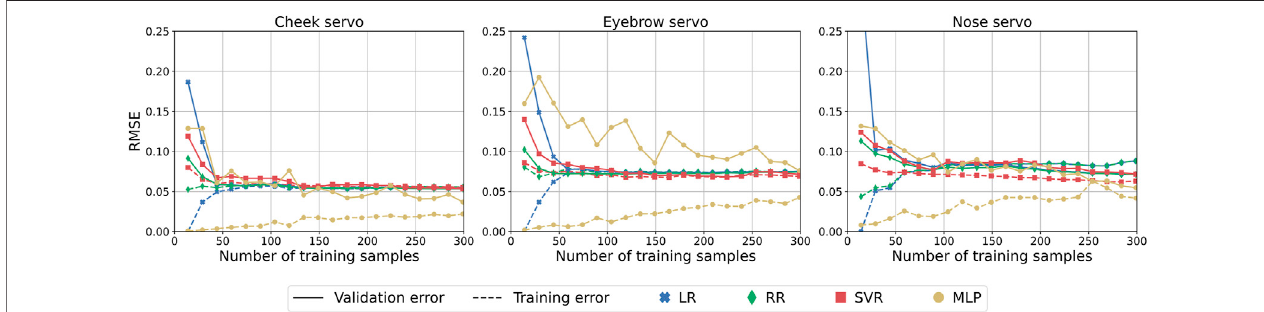
FIGURE 8 | Learning curves showing the effect of training samples on validation and training